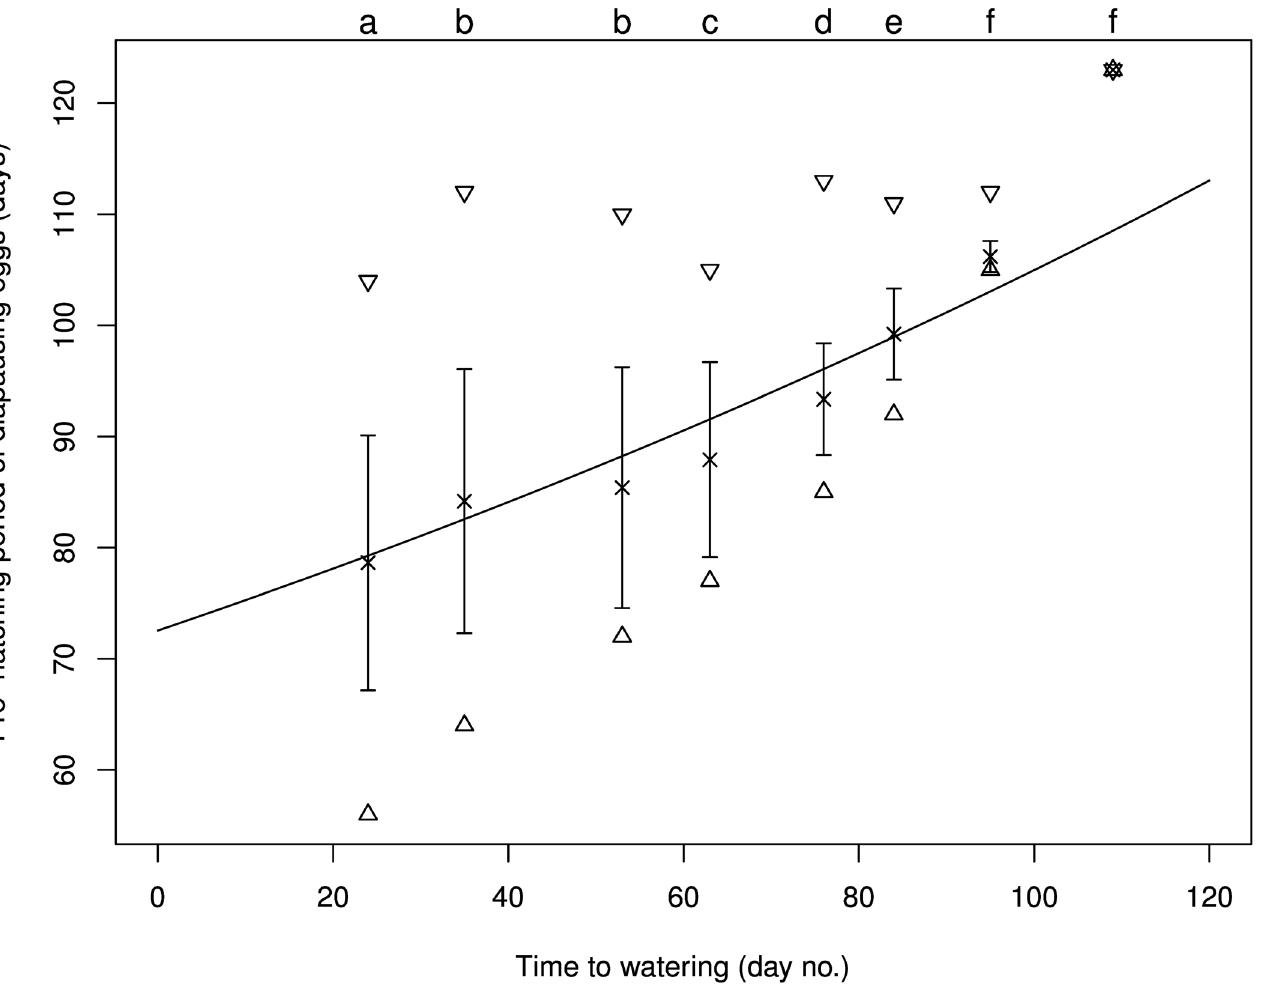
Fig 2. Relationship between pre-hatching period ( P ) of diapausing eggs and time to watering ( T 1 ) under warm long day conditions. The triangle ( Δ ), inverted triangle, the cross (×) and bar ( ┬ ) indicate the minimum, maximum, mean and standard deviation of the pre-hatching period in each treatment, respectively. The time to watering ( T 1 ) was 24, 35, 53, 63, 76, 84, 95 and 109 days, respectively. The exponential curve indicates the relationship ( P = 72.53 exp (0.0037 T 1 )) between the pre-hatching period and time to watering.